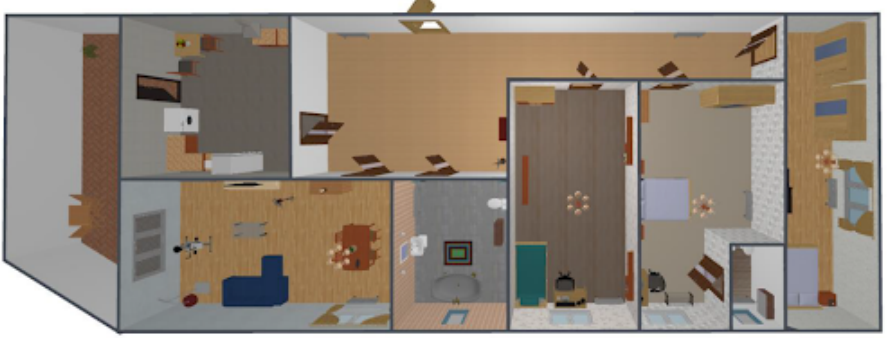
Figure 23. Floor plan of the